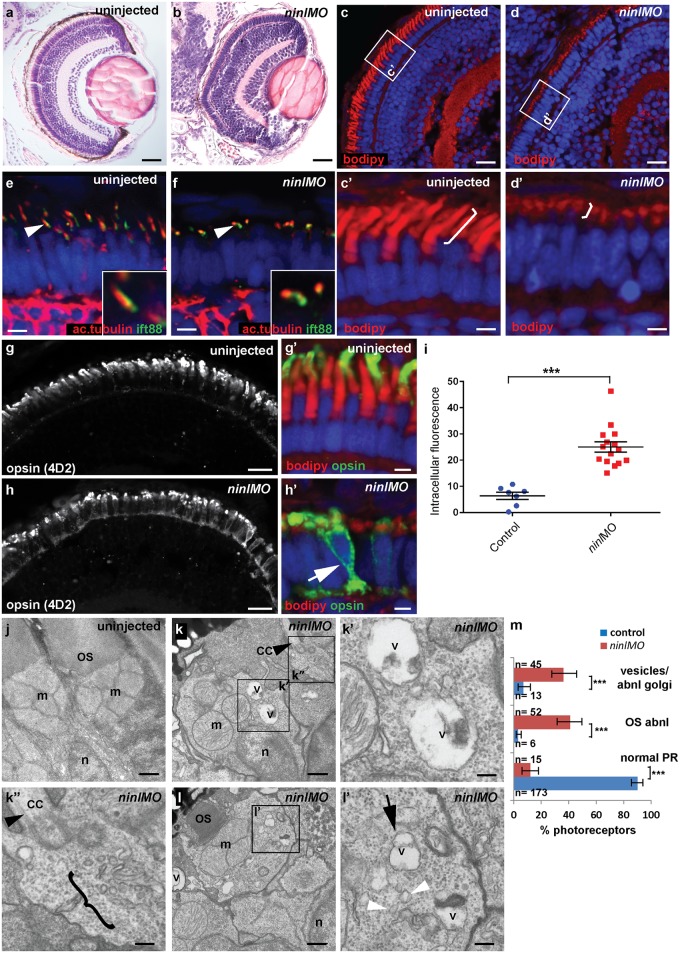
Zebrafish ninl knockdown causes loss of axonemes and outer segments, opsin mislocalization and vesicle/vacuole accumulation.(a-b) Paraffin sections stained with Hematoxylin/Eosin of control (a) and ninl knockdown larvae (b) demonstrating shortened outer segments and grossly preserved retinal lamination in the morphants. (c-d’) Bodipy-stained cryosections highlight the shortened (brackets c’-d’) and dysmorphic outer segments of ninl knockdown larvae (d and d’) compared to the long cone- or rod-shaped outer segments of controls (c and c’). (e-f) Axonemes and connecting cilia marked with anti-acetylated alpha-tubulin and anti-Ift88 antibodies are severely shortened and reduced in numbers in ninl knockdown larvae (arrowhead in f). (g-h’) Immunofluorescence with anti-opsin antibody 4D2 demonstrates mislocalization of opsins within the cell body in ninl knockdown larvae (arrow in h’) compared to controls (g) where opsins are restricted to the outer segment. (i) Quantification of the intracellular opsin accumulation in ninl morphant photoreceptors compared to control: each single datapoint in the scatter graph displays the averaged mean grey value from one larva. The mean value and the Standard Error of the Mean (SEM) are displayed as bars. The difference is statistically significant (*** = p<0.0001, Student’s t-test). (j-l’) Transmission electron microscopy of control (j) and ninl knockdown larvae (k-l’) demonstrates absent or shortened and dysmorphic outer segments (OS) and accumulation of large vacuoles (v, arrow in l’) and smaller vesicular structures (bracket in k” and white arrowheads in l’) in morphants. Black arrowheads point to the connecting cilium in k and k”. k’ and k” are the boxed areas in k and l’ is the boxed area in l. (m) Quantification of the % of photoreceptors displaying these phenotypes. Absolute numbers of photoreceptors are also indicated. Error bars indicate 95% Confidence Intervals. The differences between morphant (red bars) and controls (blue bars) are statistically significant (*** = p<0.0001, Fisher’s exact test). Larvae in all panels are 4 dpf old. Scale bars are 30 μm in a-b, 15 μm in c-d and g-h, 3 μm in c’-d’ and g’-h’, 4 μm in e-f, 0.5 μm in j-k and l and 150nm in k’-k” and l’. OS outer segment, CC connecting cilium, m mitochondria, n nucleus, v vacuole.